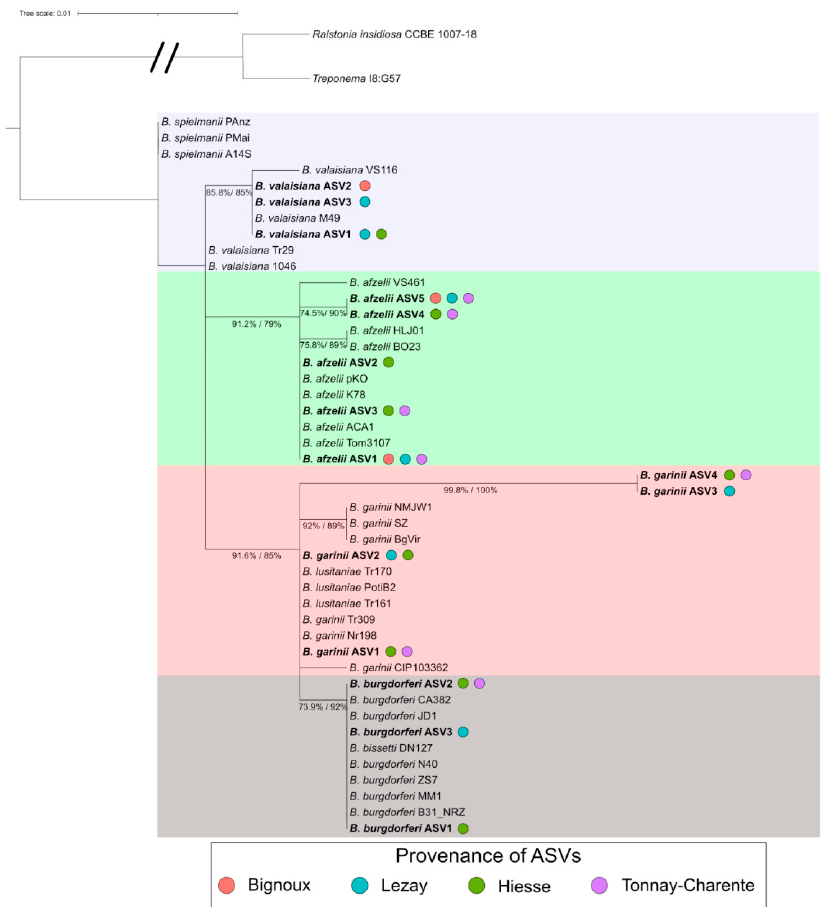
Figure 5. Phylogenetic tree of the Borreliella assigned ASVs. The tree was generated using a Kimura Two-Parameter substitution model, allowing for a proportion of invariable sites (K2P + I) model. Arbitrary colors were added to separate the four clades generated from this analysis. Colored circles indicate in which sampling sites each ASVs was found. Percentages indicate the results from the SH-like approximate likelihood ratio test and bootstraps, respectively.